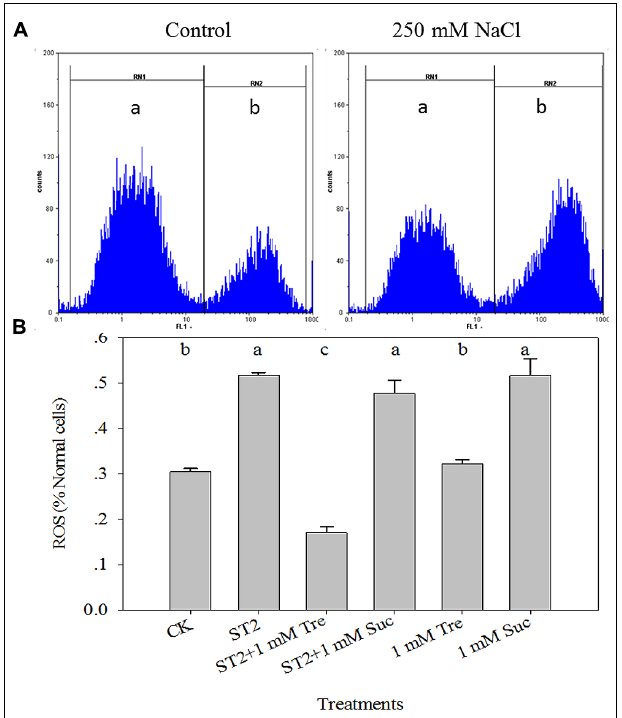
FIGURE 4 |The leaf ROS dynamics occurring in the protoplasts isolated from plants under control or high salinity conditions. (A) The schematic illustration of flow cytometry analysis of ROS levels; (B) The quantitative results of ROS levels.The protoplasts were stained with H 2 DCF-DA fluorescence solution and analyzed by FCM.The results showed are the mean ± SE of three replicates and the different letters denote the significant difference among different treatments ( P < 0.05).The zones of (a) and (b) indicate normal and ROS-occurring cells, respectively. ST2, 250 mM NaCl; ROS, reactive oxygen species;Tre, trehalose; Suc, sucrose.